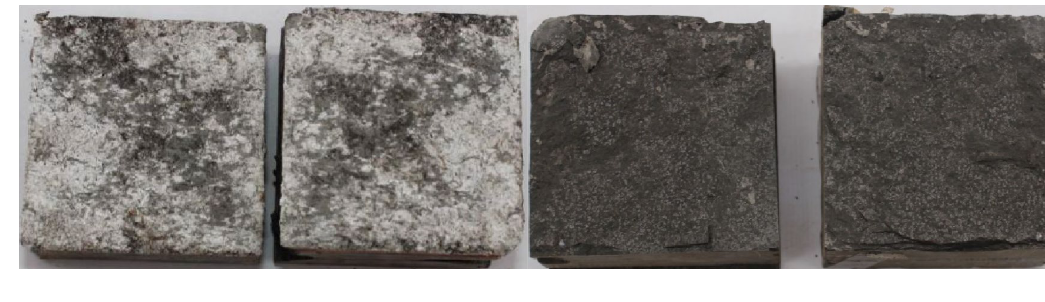
Fig. 10 Morphological characteristics of interface after shear test